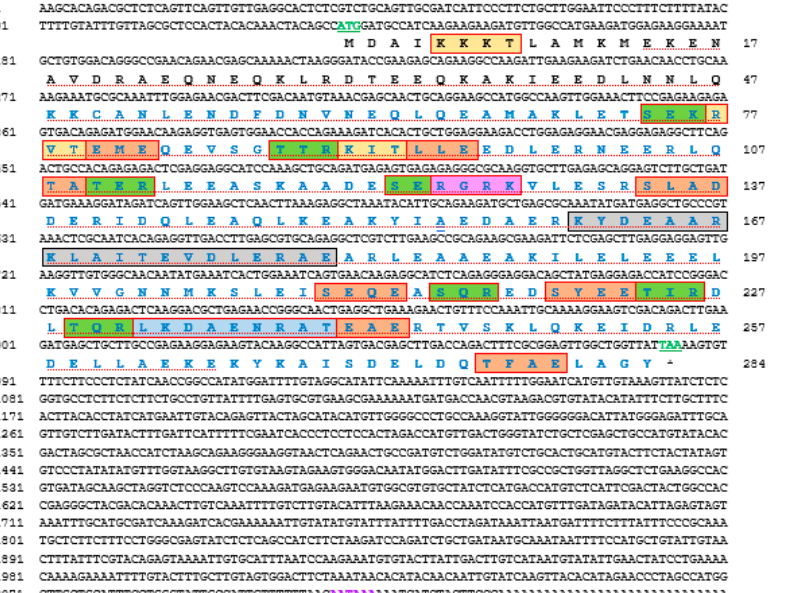
Figure 1. Full-length nucleotide and deduced amino acid sequences of Hdh-TPM (GenBank accession no. OM937906.1). The numerical numbers at the left and right side of the sequence indicate the position of nucleotide and amino acid of the Hdh-TPM gene, respectively. The coding region starts with a start codon (ATG) and ends with a stop codon (TAA), shown by green bold underline letter. The tropomyosin domain is marked with blue letters. The conserved tropomyosin signature peptide is marked with a light blue box. Cyclic adenosine monophosphate (cAMP) and cyclic guanosine monophosphate (cGMP)-dependent protein kinase phosphorylation sites are denoted by a yellow box. Potential protein kinase C phosphorylation sites are marked with a green box. Predicted casein kinase II phosphorylation sites are marked with an orange box. cAMP- and cGMP-dependent protein kinase phosphorylation sites are boxed in yellow. An amidation present in the sequence is shown with a pink box. The potential glutamic-acid-rich region profile is marked with a red dotted underline. N-terminal helix-turn-helix (HTH) site is indicated by an ash box. The putative polyadenylation signal is denoted by a violet letter with a plain underline.